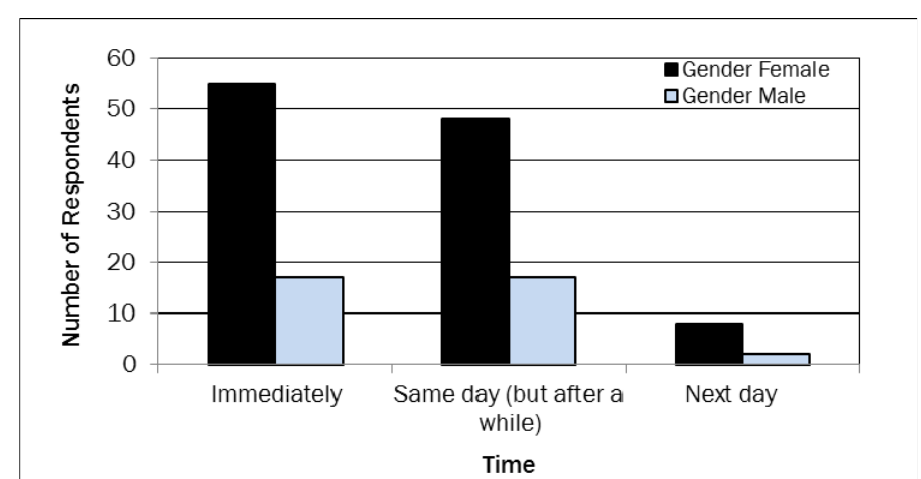
Figure 1. Time Taken Before Cooking Purchased Cowpea Leaves (Count), by Gender ( N =147)